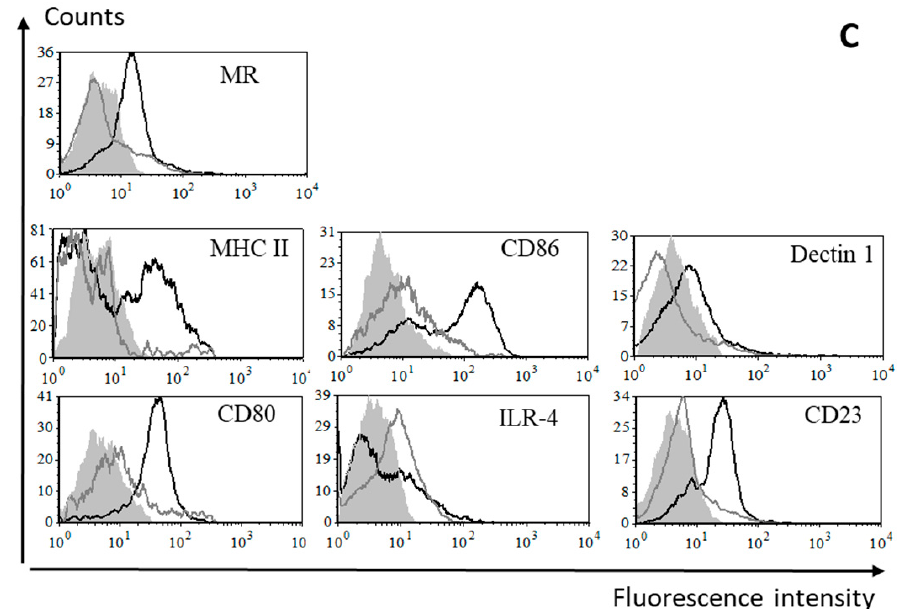
Figure 2. The level of receptor expression on CD11b + cells in the peritoneal cavity in mice infected with T. spiralis and/or injected with chitosan 5 days after infection (DAI) ( A ) and 30 DAI ( B ); representative dot plots 5 DAI ( C ): grey area—unlabeled cells, black line— T. spiralis infected mice, grey line—treated with chitosan and infected with the nematode. (*) p < 0.05, chitosan vs. non treated; ( # ) p < 0.05, infected vs. control.